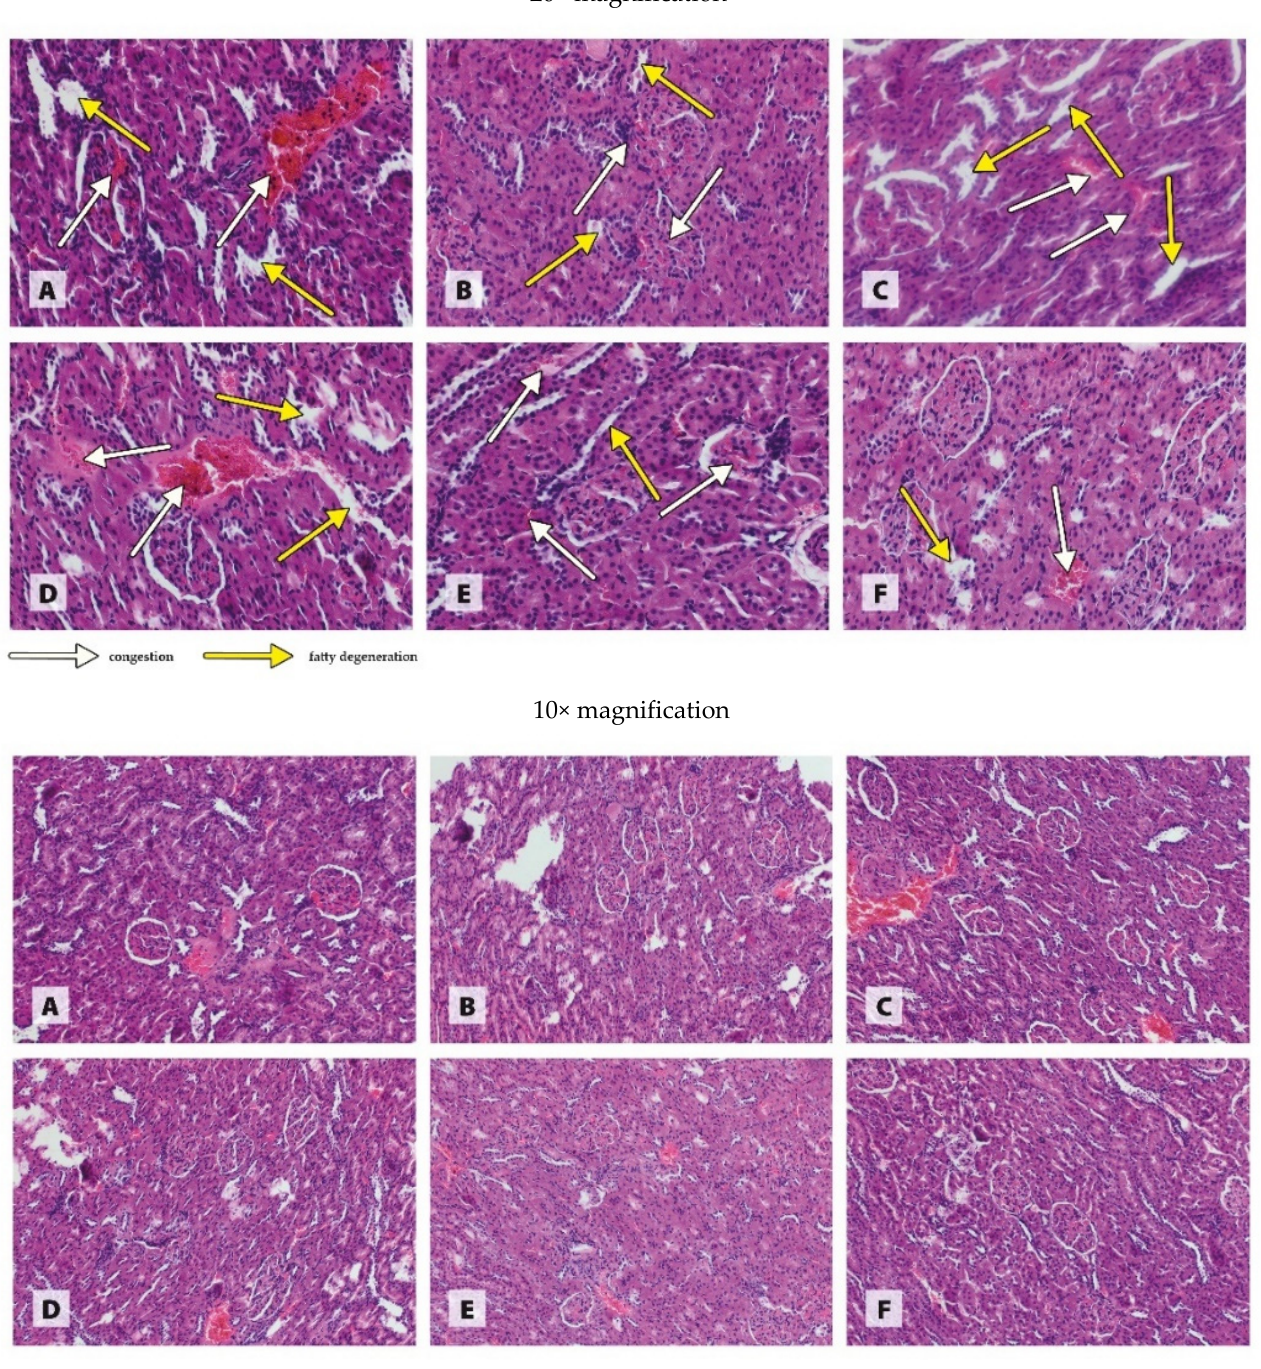
Figure 4. Morphological effects of different blood pressure and Cu sources on the kidney of rats. Treatments: ( A ) WKY CuCO 3 6.5 , ( B ) WKY CuCO 3 3.25 + CuNP 3.25 , ( C ) WKY CuNP 6.5 , ( D ) SHR CuCO 3 6.5 , ( E ) SHR CuCO 3 3.25 + CuNP 3.25 , and ( F ) SHR CuNP 6.5 .